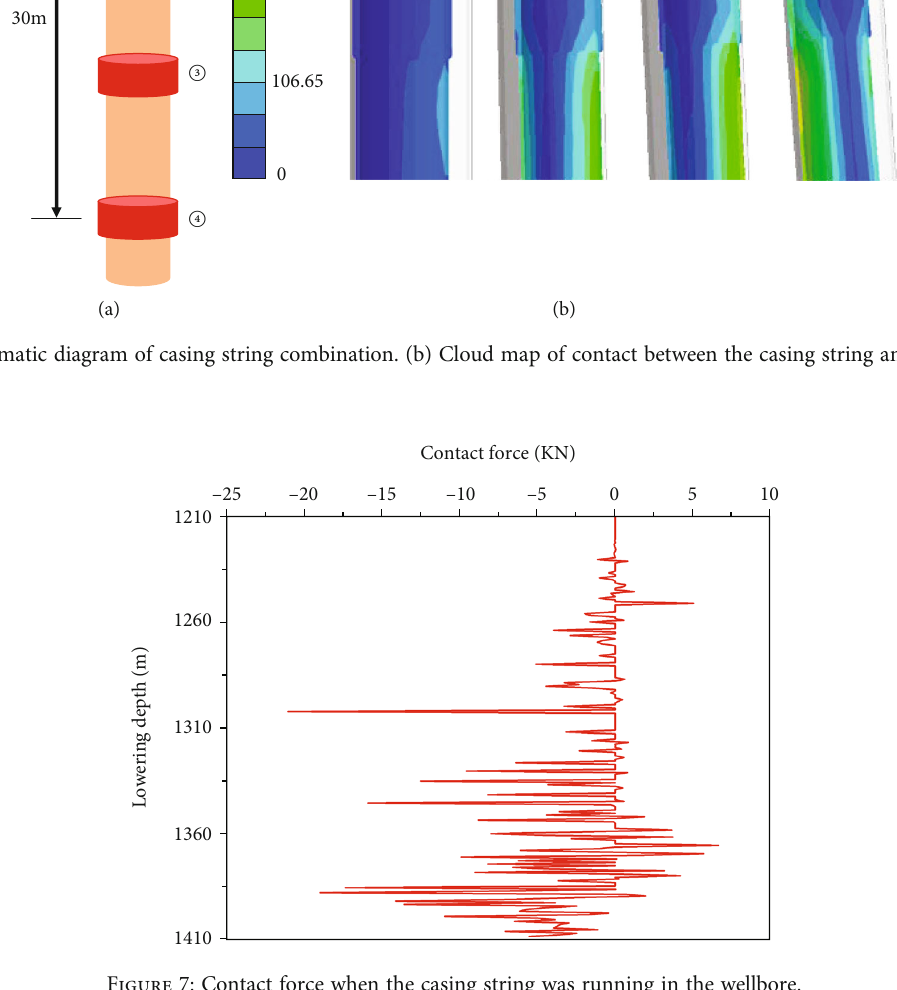
Figure 7: Contact force when the casing string was running in the